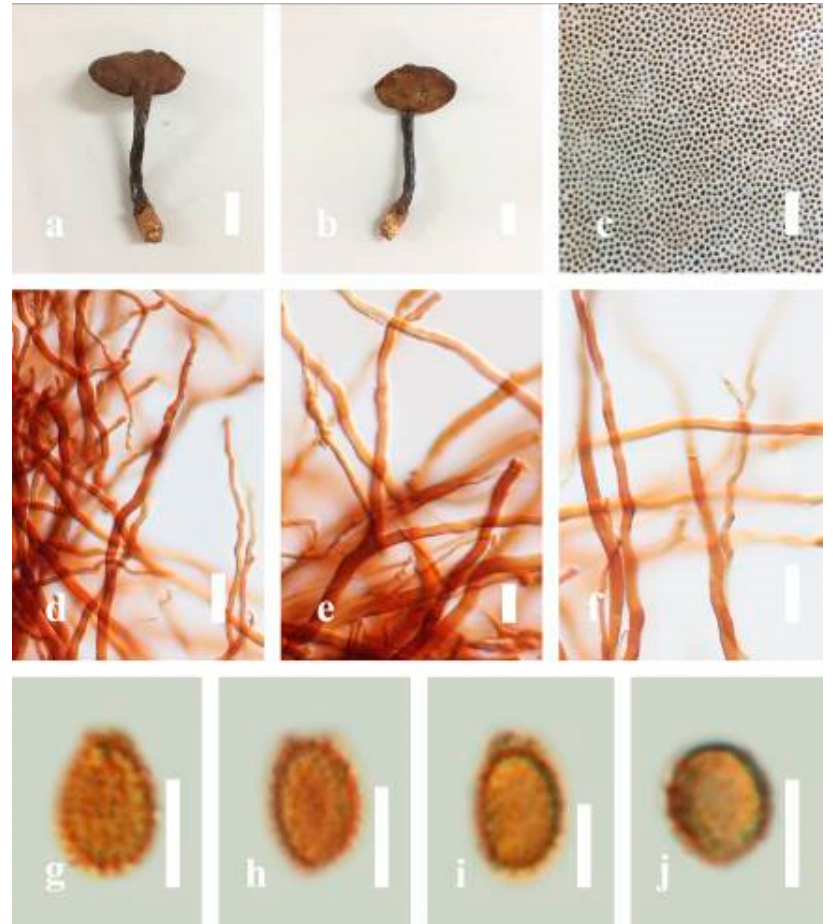
Figure 31. Morphology of Ganoderma sinense (MFLU 19 ‐ 2172): ( a , b ) mature basidiomes; ( c ) pore characteristics; ( d – f ) generative skeletal and binding hyphae of context in KOH; ( g – j ) basidiospores in KOH. Scale bars: ( a , b ) = 2 cm, ( c ) = 1000 μ m, ( d – f ) = 20 μ m, ( g – j ) = 5 μ m. Ganoderma subresinosum (Murrill) C.J. Humphrey, Mycologia. 30 (3): 332 (1938)